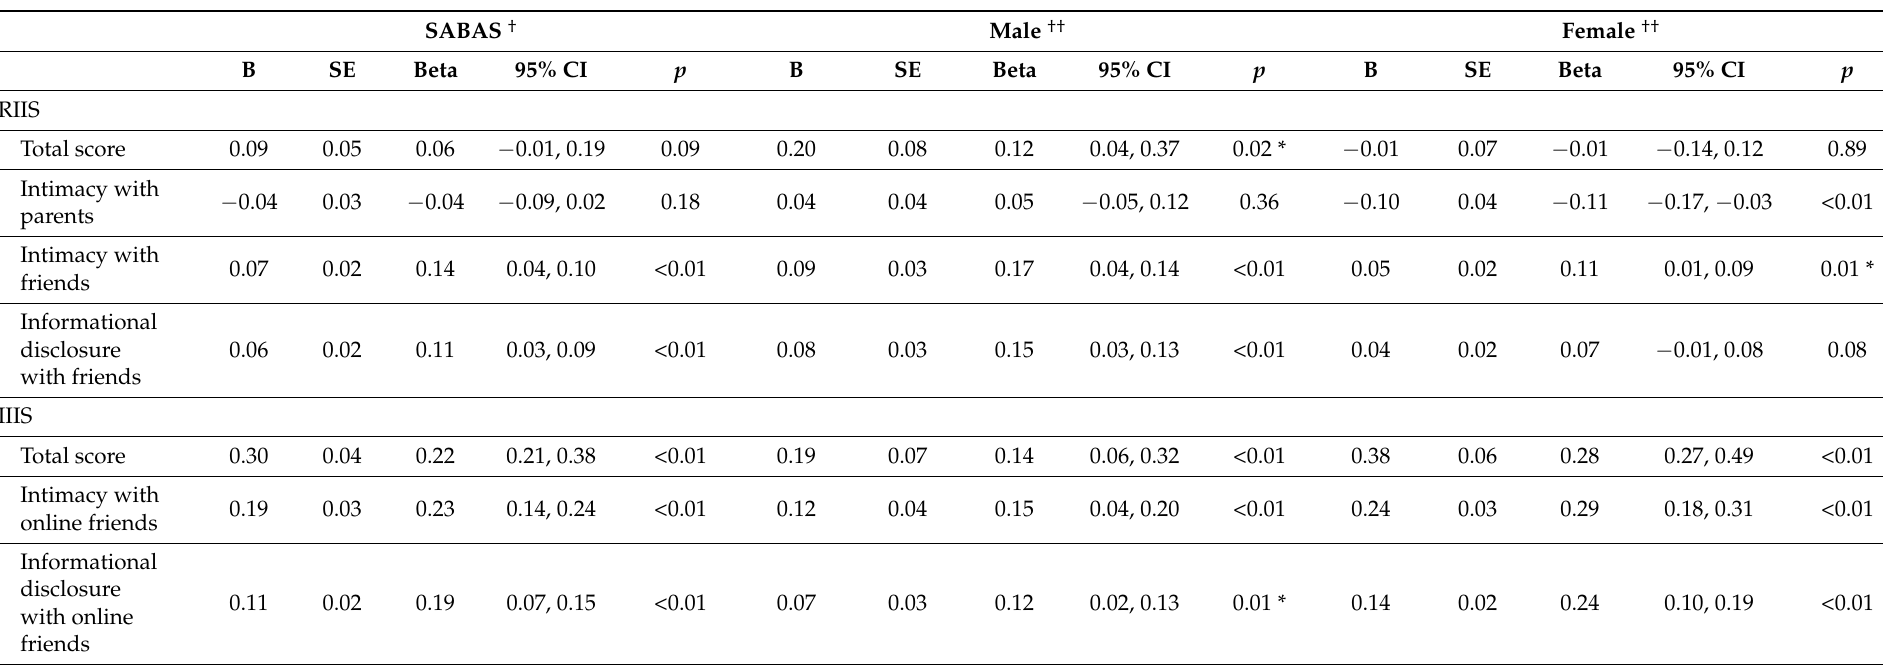
Table 3. Multiple regression analysis for identifying Real Interpersonal Interaction Scale (RIIS) /Internet Interpersonal Interaction Scale (IIIS) with their dimensions significantly related to Smartphone Application-Based Addiction Scale